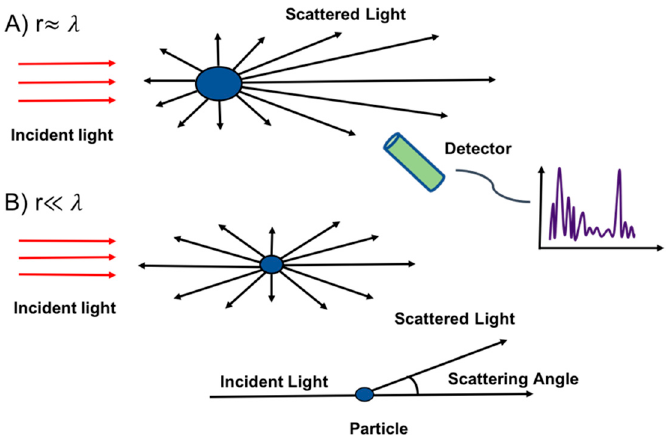
Figure 2. Light scattering principle. ( A ) the Mie theory for large particles, ( B ) the Ryleigh theory for small scale particles.